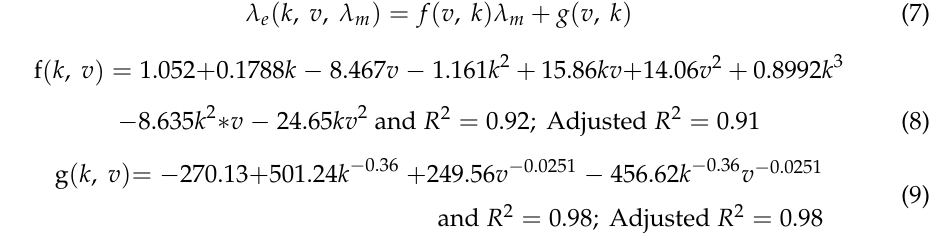
Figure 6. Effect of thermal conductivity of matrix on effective thermal conductivity of cast iron, v =